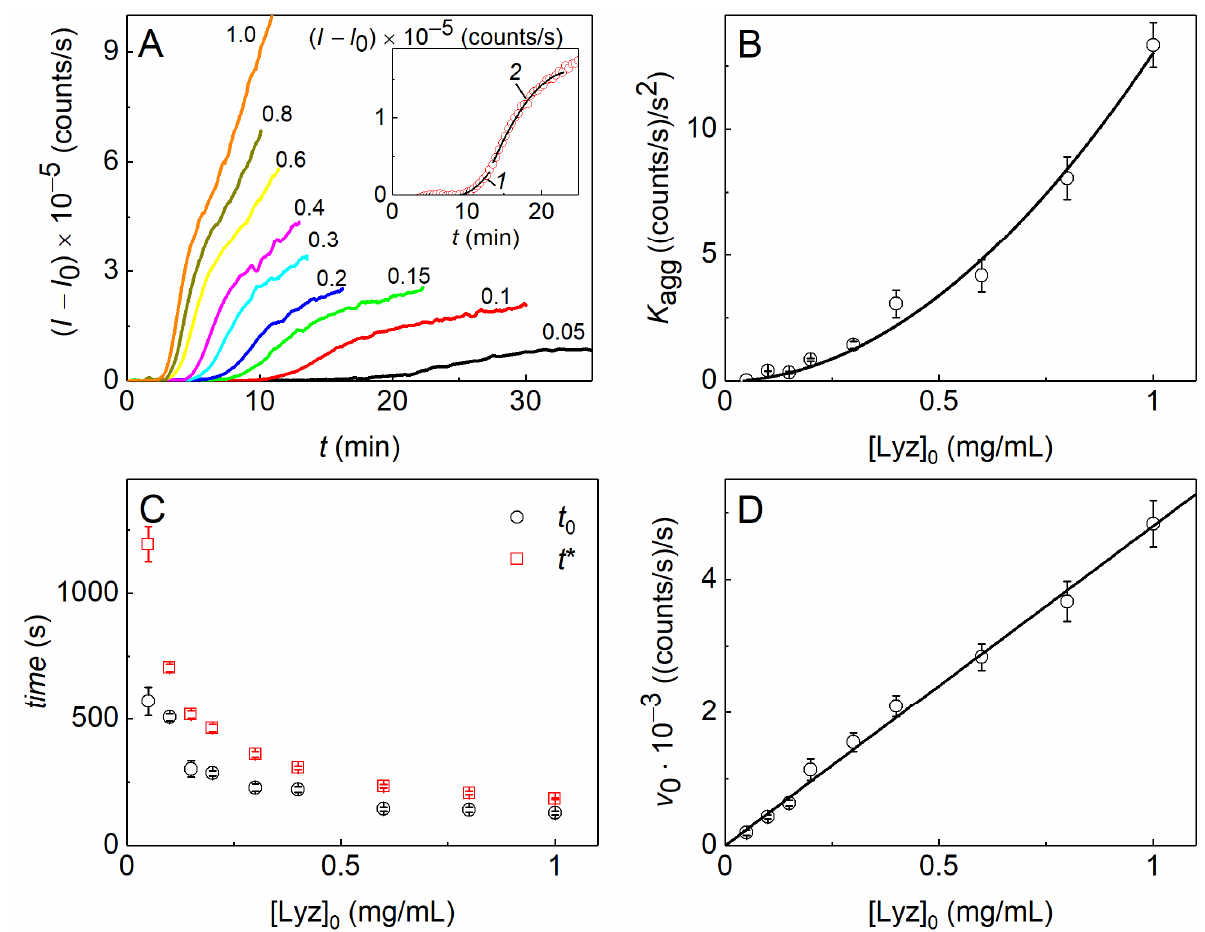
Figure 1. The kinetics of DTT-induced aggregation of Lyz (0.1 M Na-phosphate buffer, pH 7.6, 10 mM NaCl, 20 mM DTT) at 37 °C. ( A ) The growth of the light-scattering intensity from its initial value ( I − I 0 ) over the time ( t ) at different initial concentrations of Lyz (numbers near the curves correspond to Lyz concentration in mg/mL). The inset shows the kinetic curve for 0.1 mg/mL Lyz as an example of calculating the kinetic parameters: curves 1 and 2 are calculated using Equations (1) and (2), respectively. ( B ) The dependence of K agg on the initial concentration of Lyz. The solid curve was calculated using Equation (3), with b = 1.94 ± 0.13. ( C ) The dependence of t 0 and t * on the initial concentration of Lyz. ( D ) The dependence of v 0 on the initial concentration of Lyz. The solid curve was calculated using Equation (4), with c = 0.96 ± 0.04.